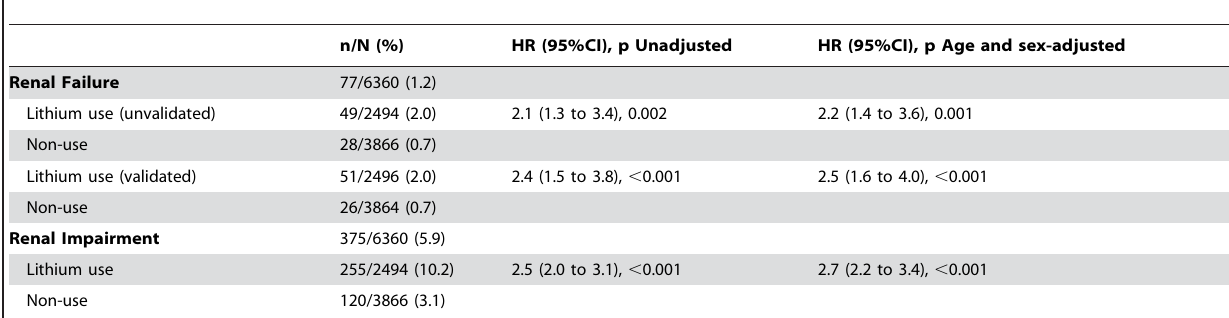
Table 2. Unadjusted and adjusted hazard ratios for renal failure and renal impairment among lithium users and non-users.